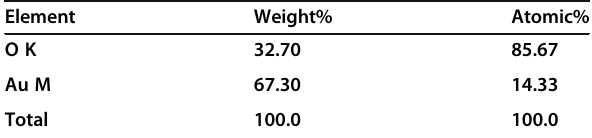
Table 1 EDAX analysis of the nanoparticles